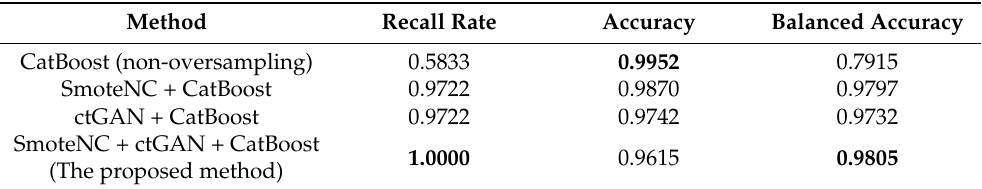
Table 14. Prediction results obtained for the OSF diagnosis using other methods used for processing limited data.